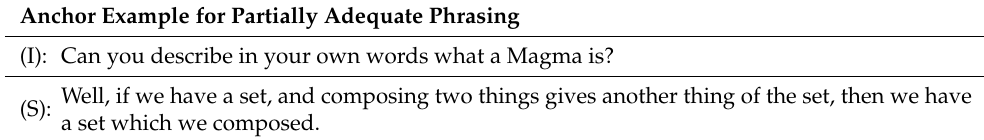
Table 7. Partially adequate paraphrasing of Participant H and P6 (cf. Table A6 in the Appendix A). Anchor Example for Partially Adequate Phrasing